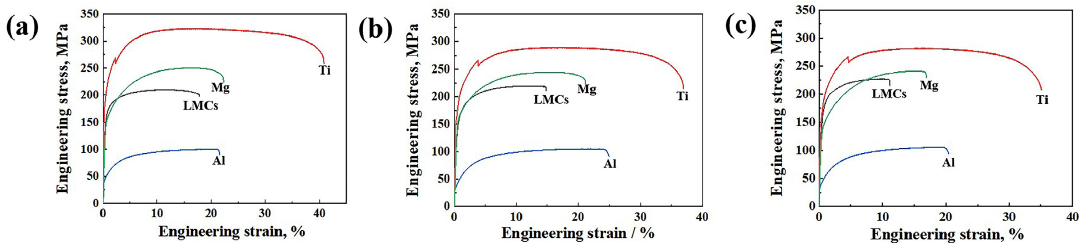
Figure 12. Engineering stress-strain curves of monolithic Ti, Al, Mg sheets and LMCs at the temperature of (a) 350 o C (b) 400 o C and (c) 450 o C. Table 2. Mechanical properties of monolithic Ti, Al and Mg sheets heat-treated at different temperatures. Temperature, o C